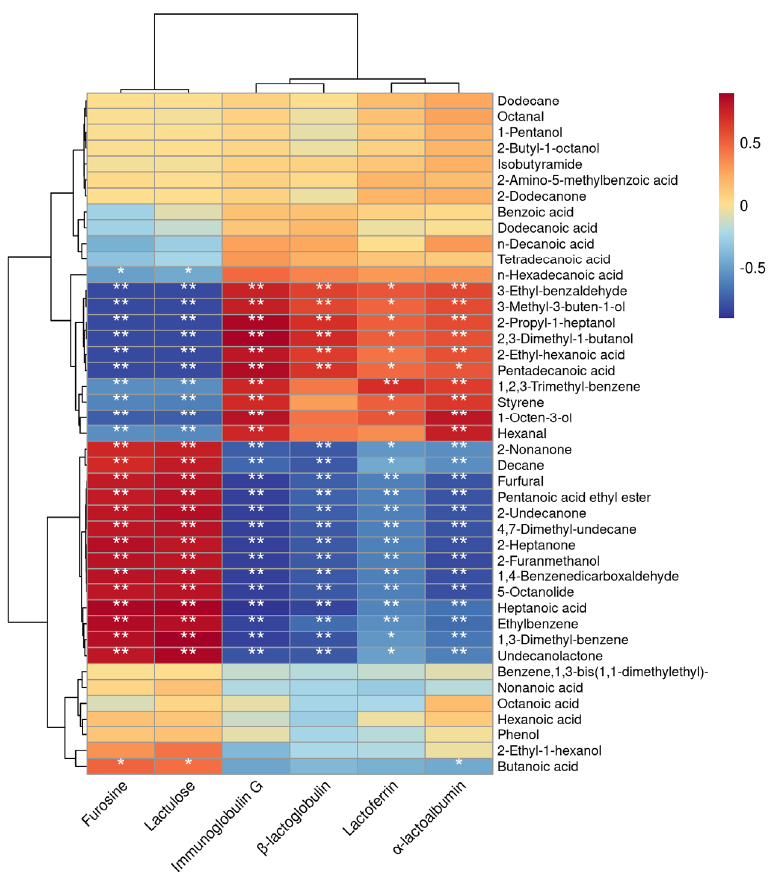
Figure 7. Correlation analysis between thermal parameters and VOCs (** p < 0.01, * p < 0.05).